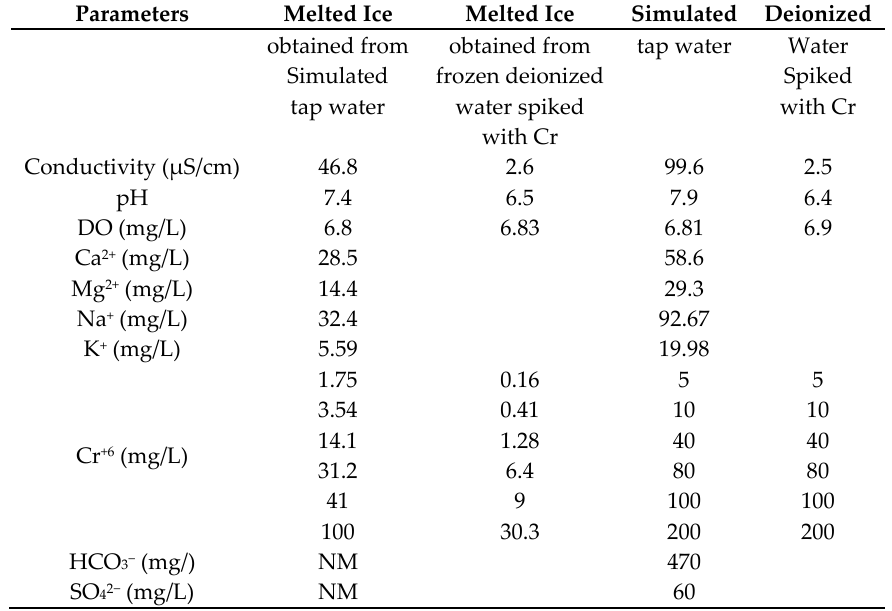
Table 1. Physicochemical properties of water tested (initial conditions) and melted ice [27]. Parameters Melted Ice Melted Ice Simulated Deionized obtained from obtained from tap water Water Simulated frozen deionized Spiked tap water water spiked with Cr with Cr Conductivity ( μ